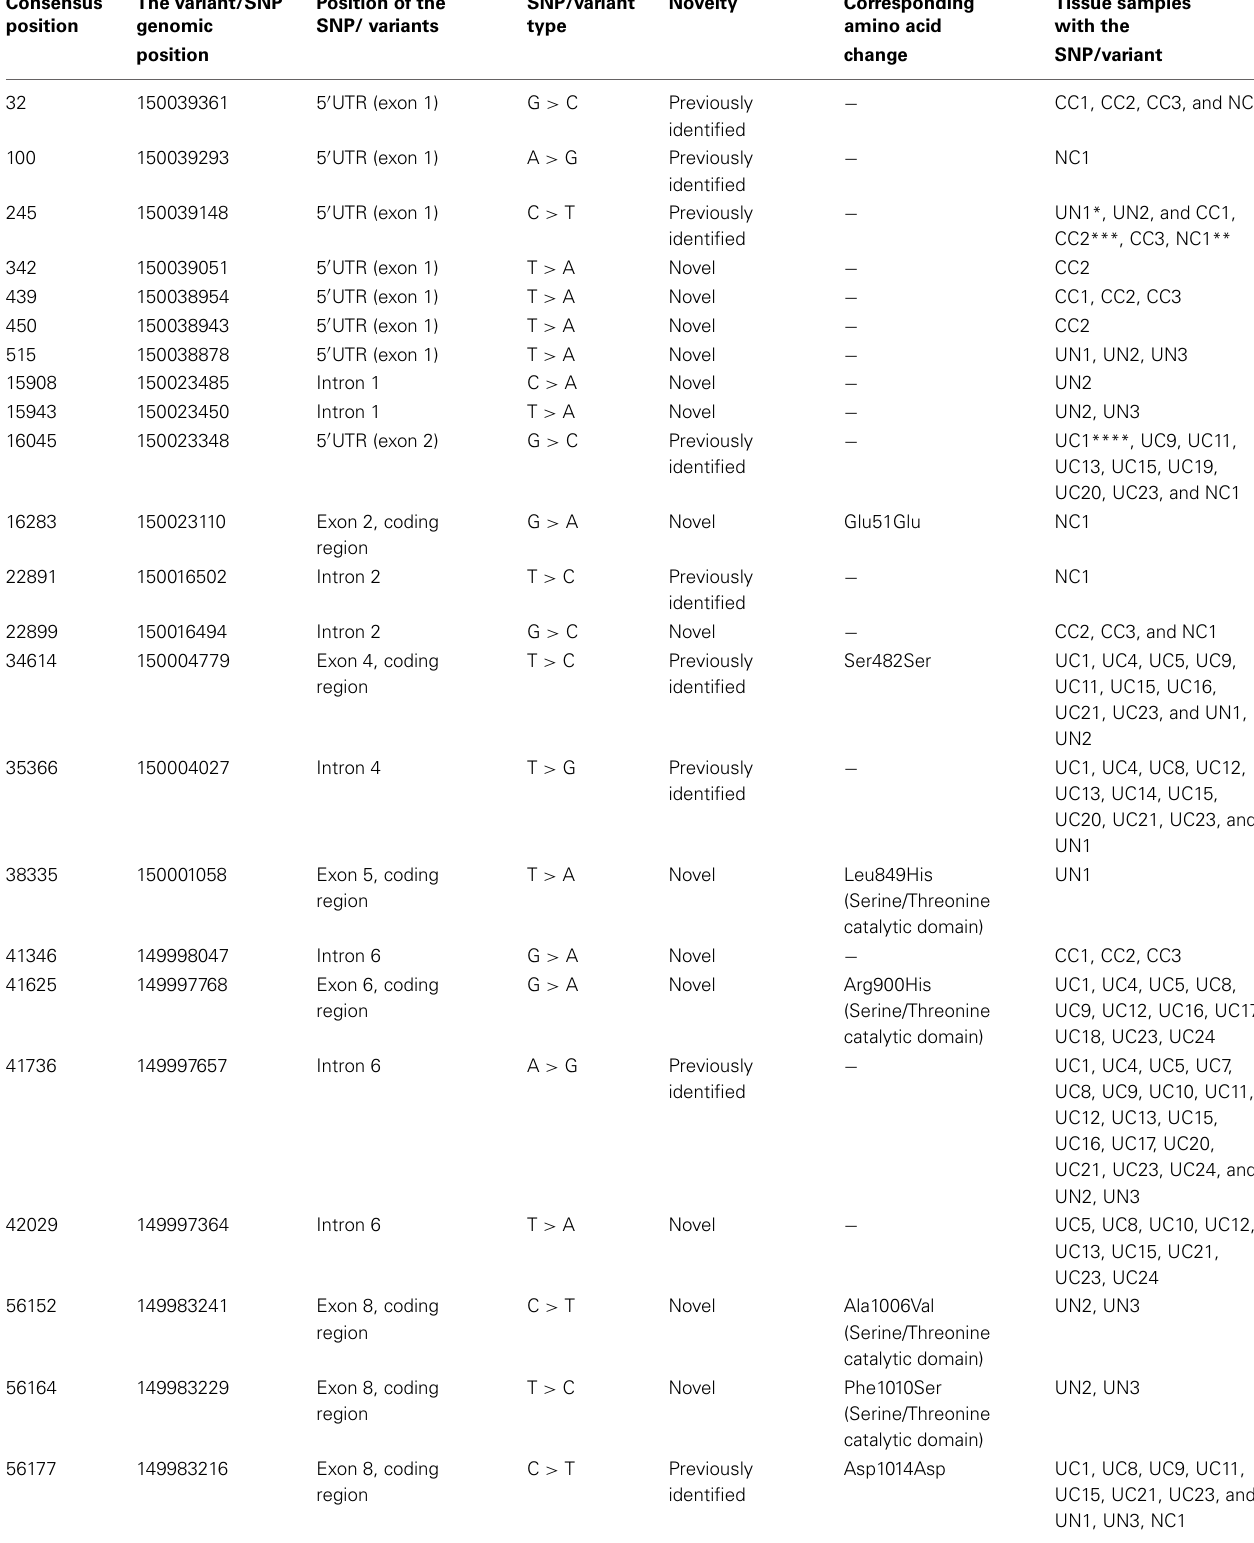
Table 2 | Summary of the SNPs/variants detected in the LATS1 gene.